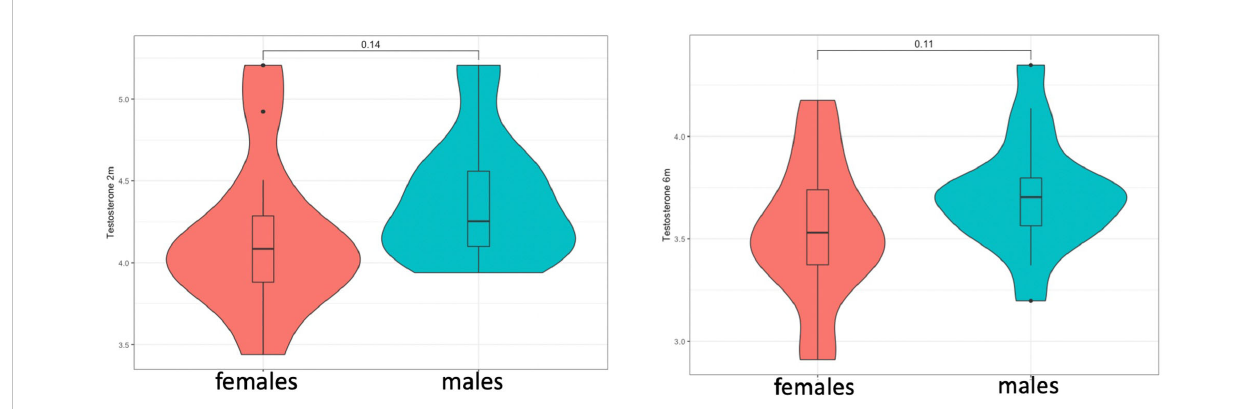
FIGURE 1 Testosterone levels at 2 (left) and 6 months (right) did not show signi fi cant sex differences but showed a consistent trend for higher levels in